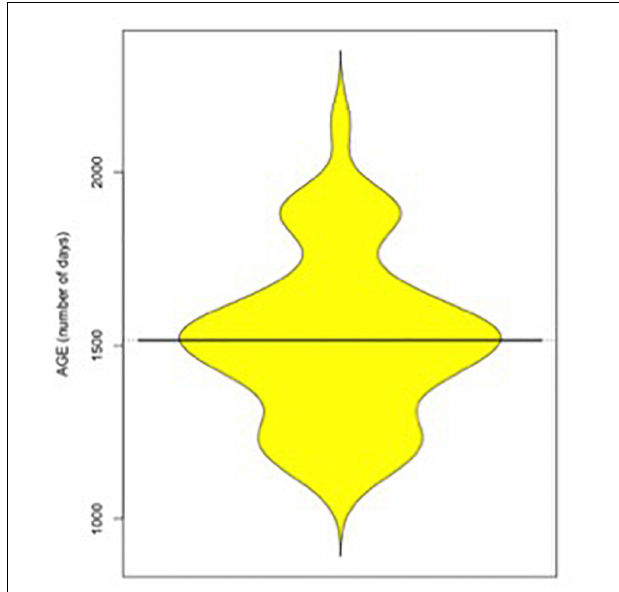
FIGURE 1 | Beanplot of the age